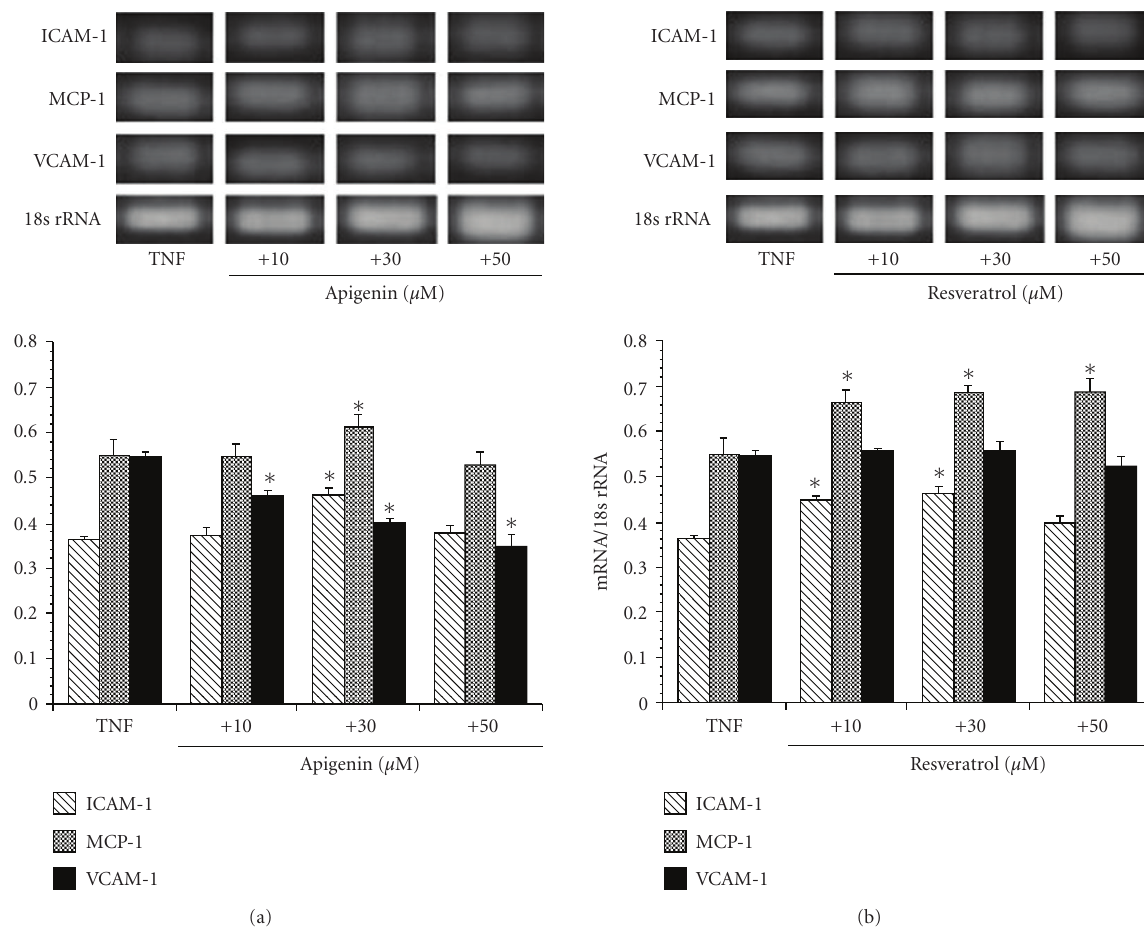
Figure 4: The e ff ects of apigenin and resveratrol on TNF- α -induced expression of ICAM-1, MCP-1, and VCAM-1 in astrocytes isolated from SHRSP/IZM. Dose response: the astrocytes isolated from SHRSP/IZM were washed with FBS-free DMEM, replaced with DMEM containing TNF- α (10ng/mL), and supplemented with 0, 10, 30, or 50 μ M of apigenin (a) or resveratrol (b). They were then incubated for 4 hours. The ICAM-1, MCP-1, and VCAM-1 mRNA measurements were carried out as described in Figure 1 and in the text. The bars represent the mean ± SD ( n = 4). Asterisk ( ∗ ): P < . 05 compared with the basal TNF- α value. TNF: TNF- α .